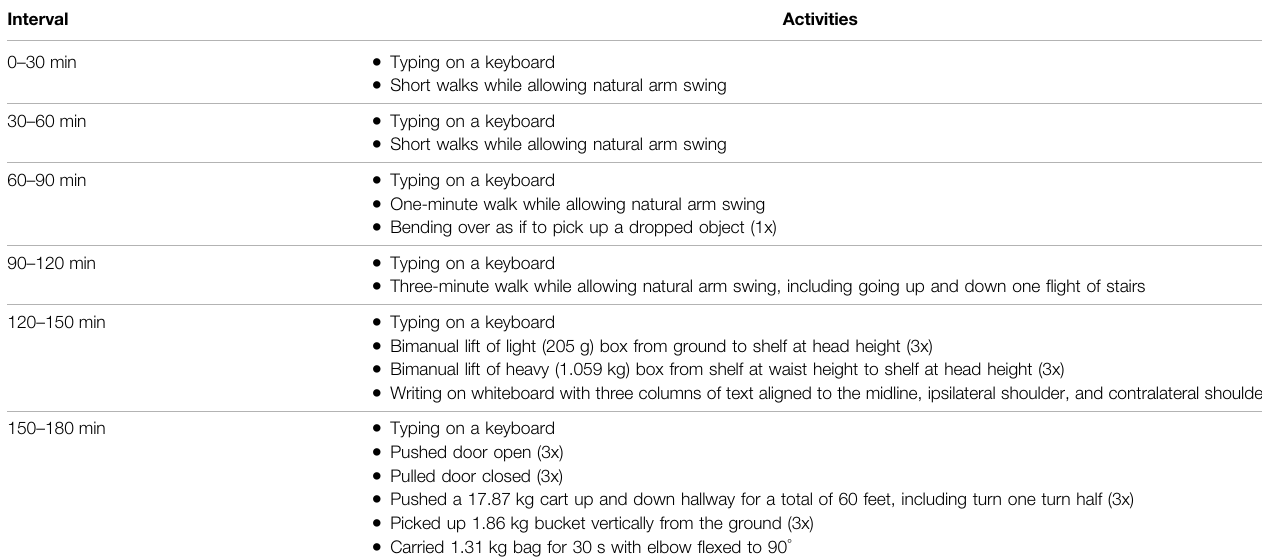
TABLE 2 | Activities performed during each break in the 3-h testing. All activities were performed with the arm wearing the sonomyographic prosthesis. The clinically- prescribed myoelectric prosthesis was worn on the contralateral arm for the bimanual activities. The TASKA hand was not turned on during these breaks, but the participant was able to passively manipulate objects using the